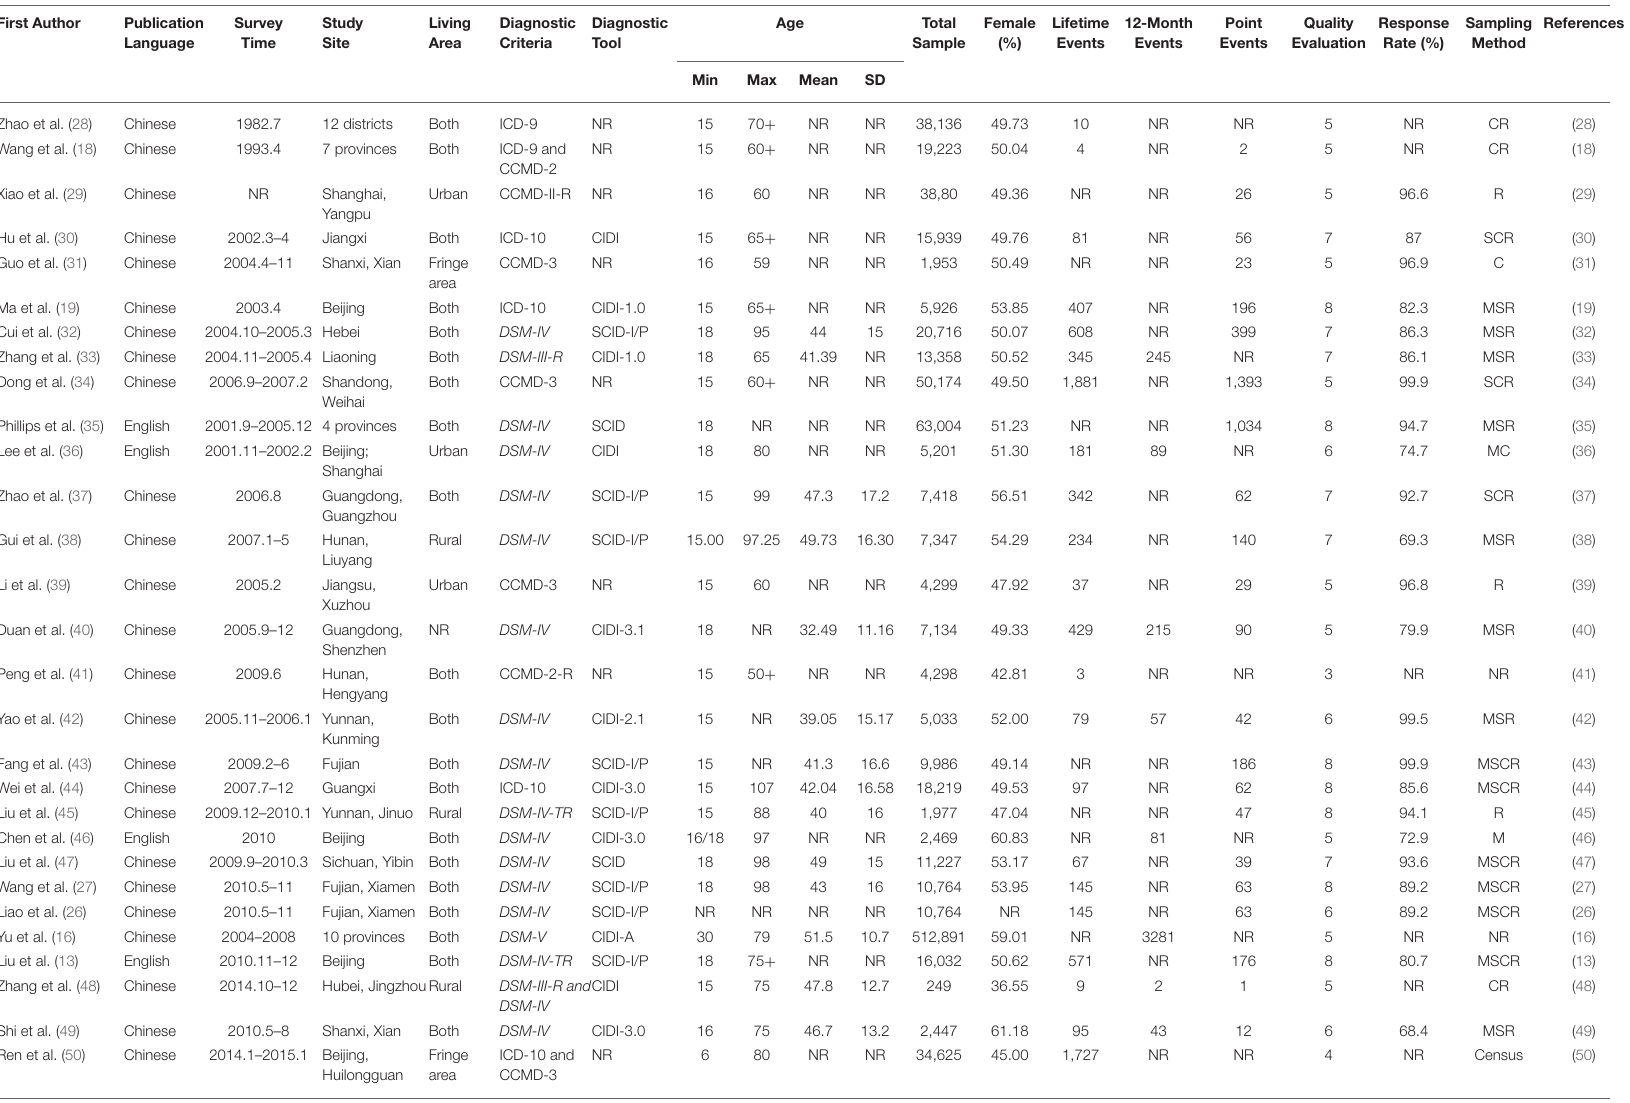
TABLE 1 | Characteristics of studies included in this